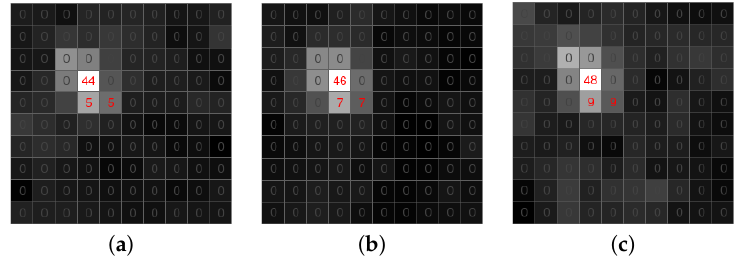
Figure 13. The counters of a negative candidate associated with pixels labeled as a candidate